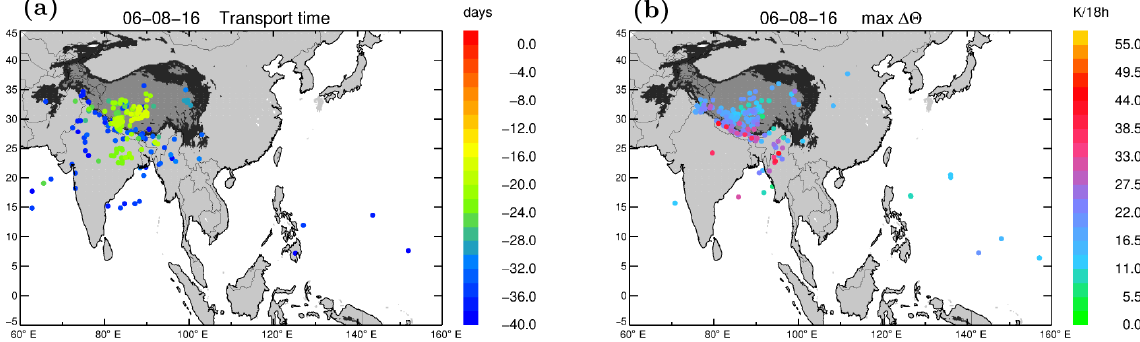
Figure 6. (a) Location of end points of the trajectories, initialised on 6 August within the ATAL, where they reach the model boundary layer (BL) within 40d. The end points are colour-coded by the transport time between the BL and measurement. (b) Location of the strongest updraft along the 40-day backward trajectories, colour-coded by the strongest change in potential temperature within 18h (in kelvin per 18 hours, K18h − 1 ). The Tibetan Plateau (“Tibet”; dark grey), the Himalayan foothills (“Foothills”; black), the remaining continental area (“Land”; light grey) and the maritime area (“Ocean”; white) are indicated (see Table